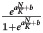
Proportion of shelter cats adopted.The annual proportion of cats being adopted from shelters was assumed dependent on owned cat carrying capacity following a 2-term logistic regression eaNK+b1+eaNK+b where a = -12, b = 12, N is the owned cat population size, and K is the owned cat carrying capacity. The reference line is the dashed line at the point where the probability of adoption is 0.5 and the population of owned cats is at carrying capacity.